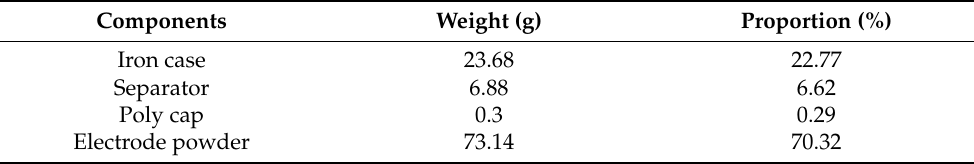
Table 1. Weight and proportions of the spent nickel–metal hydride battery parts after physical separation.